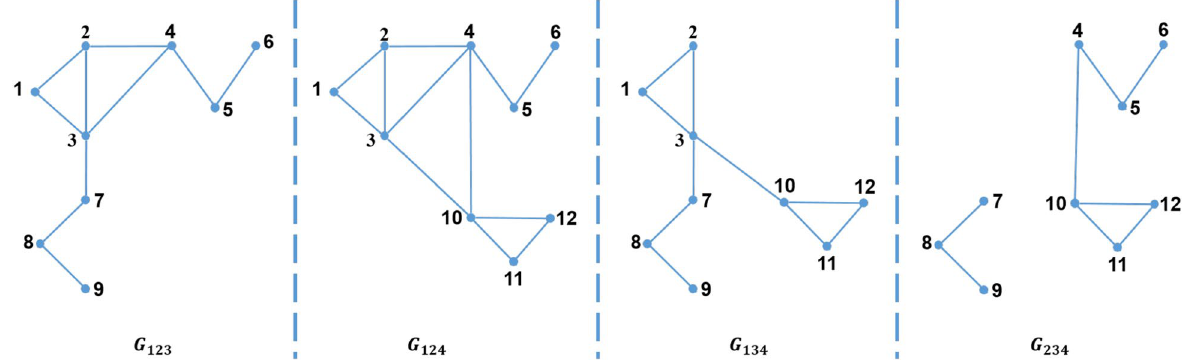
Figure 5. 3-partition of the graph in Fig.